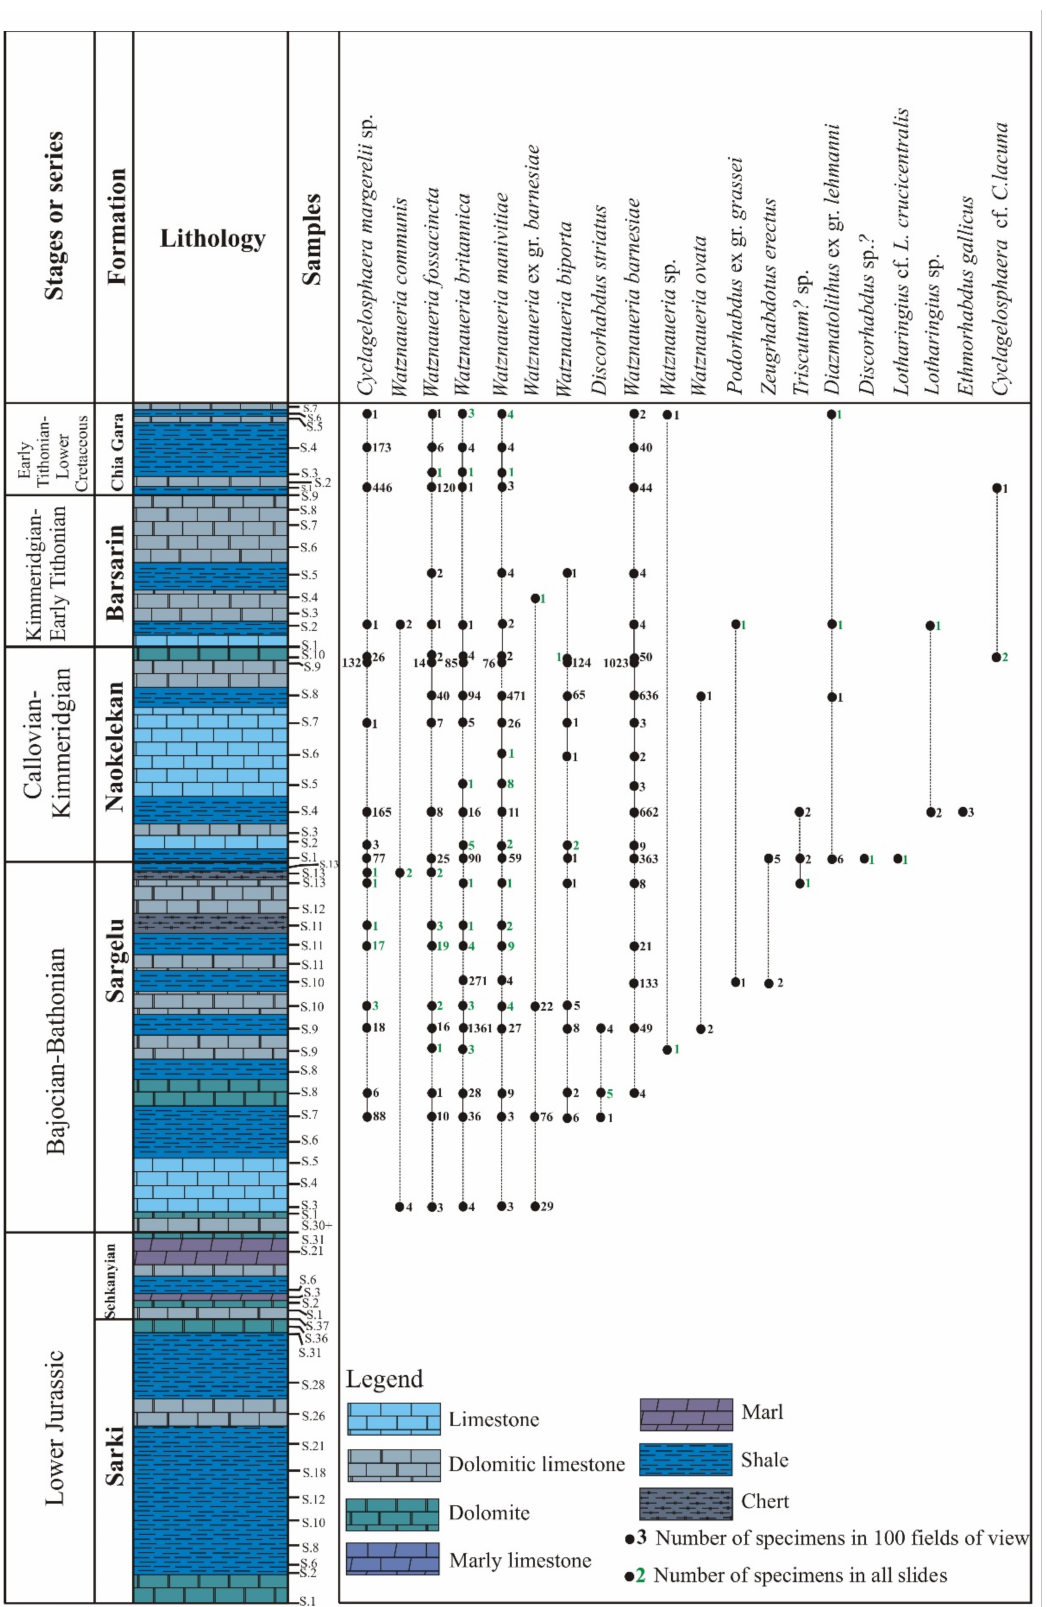
Figure 2. Sample location and distribution of the calcareous nannoplankton of the Warte